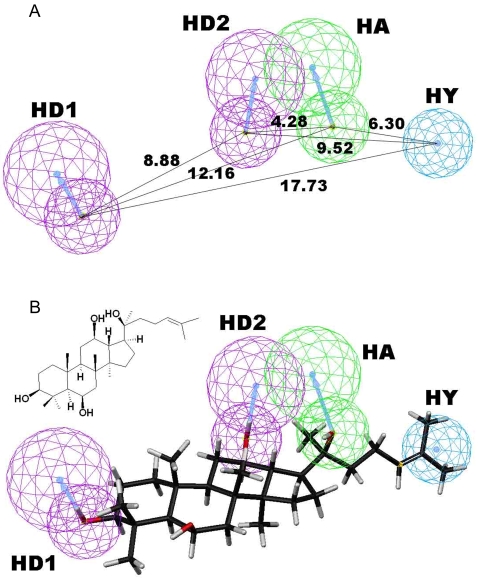
Shape-based pharmacophore model of the inhibition of Vivid® CYP3A4 green activity by ginsenosides.The model was generated from the 3D structure of PPT and its activities against CYP3A4. PPT fitted into the model was shown in the figure. Blue represents the shape space, black represents carbon atoms, red represents oxygen atoms, and white represents hydrogen atoms.